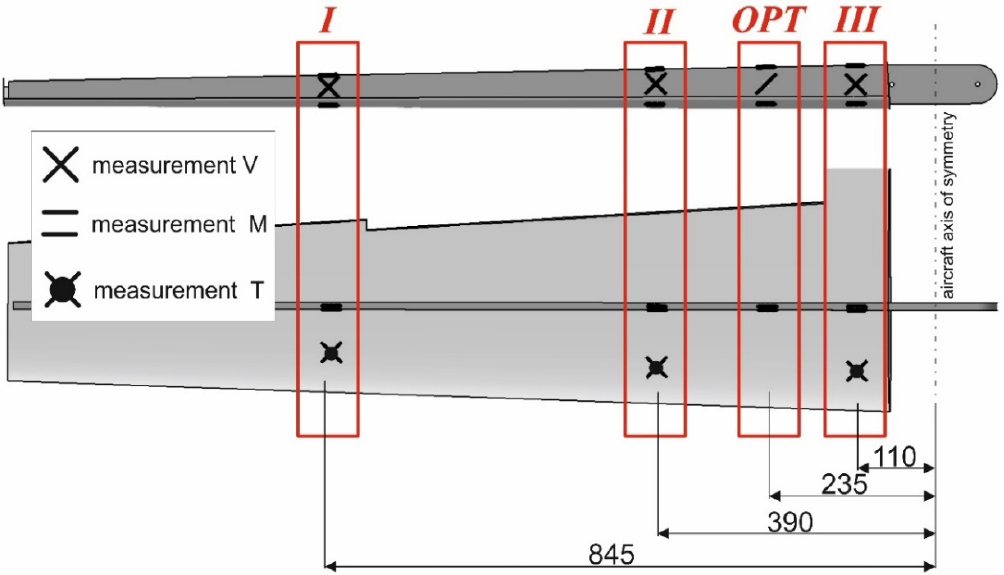
Figure 4. Strain gauges positions inside the wing structure (dimensions in mm).